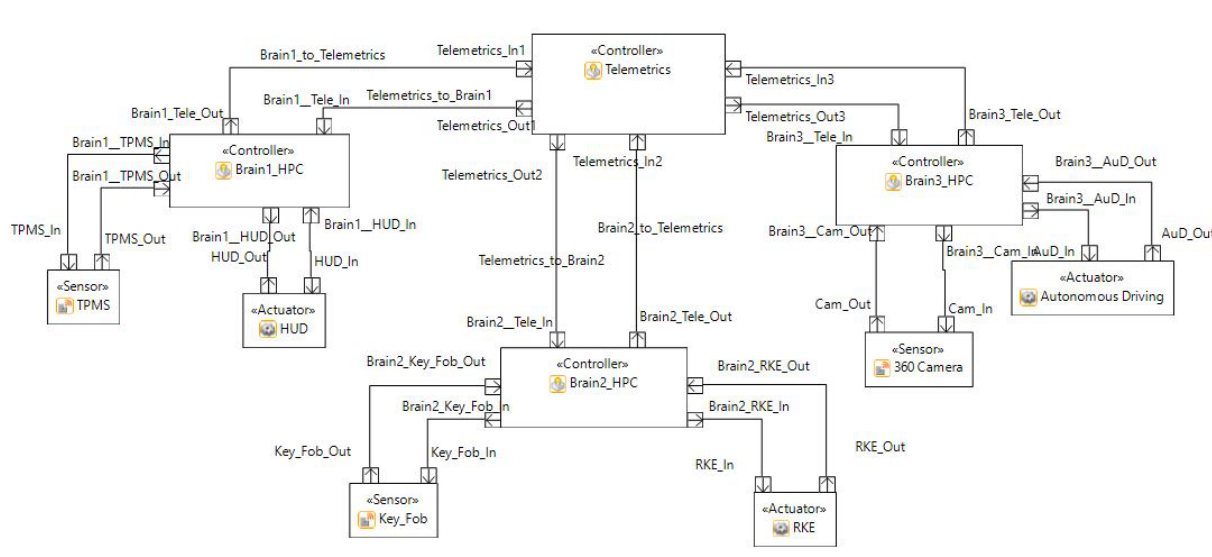
Figure 18. Realization of Three-Brain Architecture in Ansys Medini